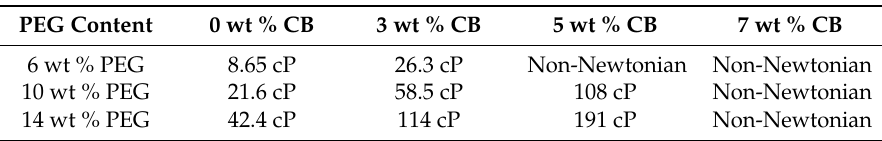
Table 1. Viscous behavior of mixtures prepared with various carbon black (CB) and polyethylene glycol bisphenol A, epichlorohydrin copolymer (PEG) amounts. Samples indicated in bold are further